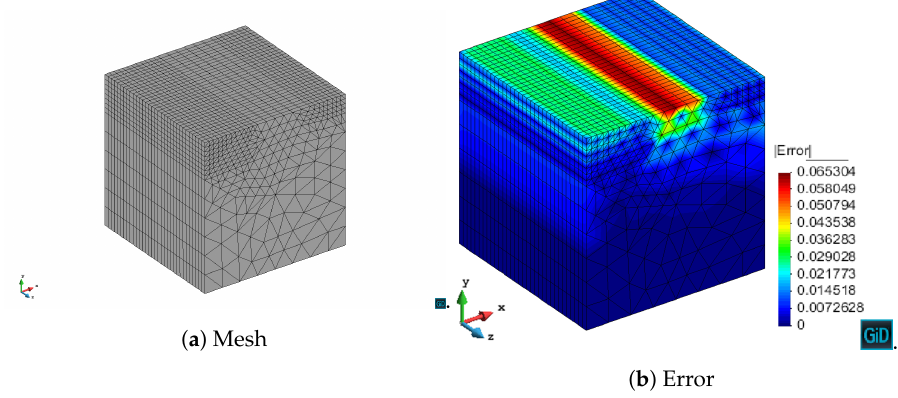
Figure 9. Approximation of (13) using the next-step marking strategy.